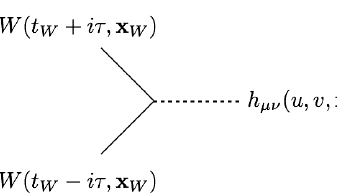
Figure 2 . Three-point diagram as a part of the bulk tree-level graviton exchange diagram. The two straight lines represent the bulk-boundary scalar propagators, and a dotted line represents the bulk- bulk graviton propagator. The interaction region is localized around the horizon because of